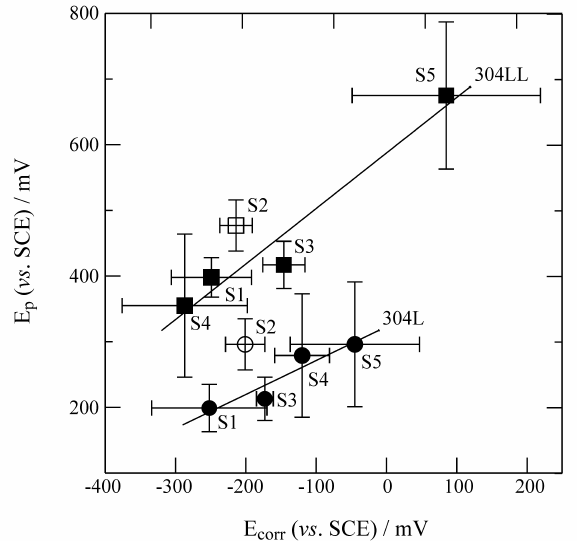
Figure 3. Correlation between pitting potential E p and corrosion potential E corr for 304L and 304LL steels.